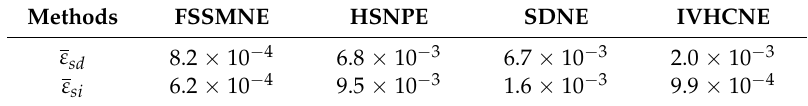
Table 1. Estimation errors of SD and SI noise on the synthetic HS image with different methods.